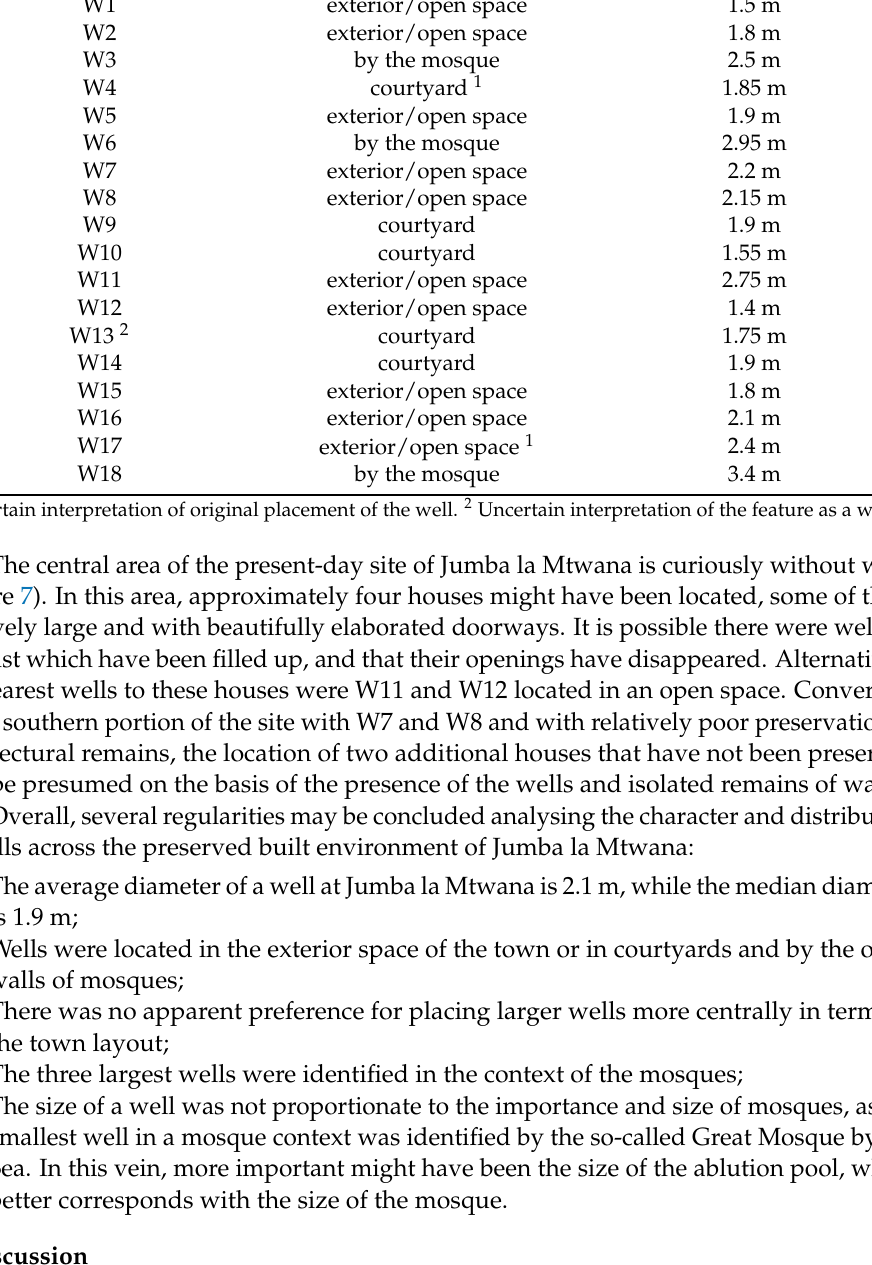
Table 1. The table shows the diameter and placement of all wells identified in the town of Jumba la Mtwana. Well